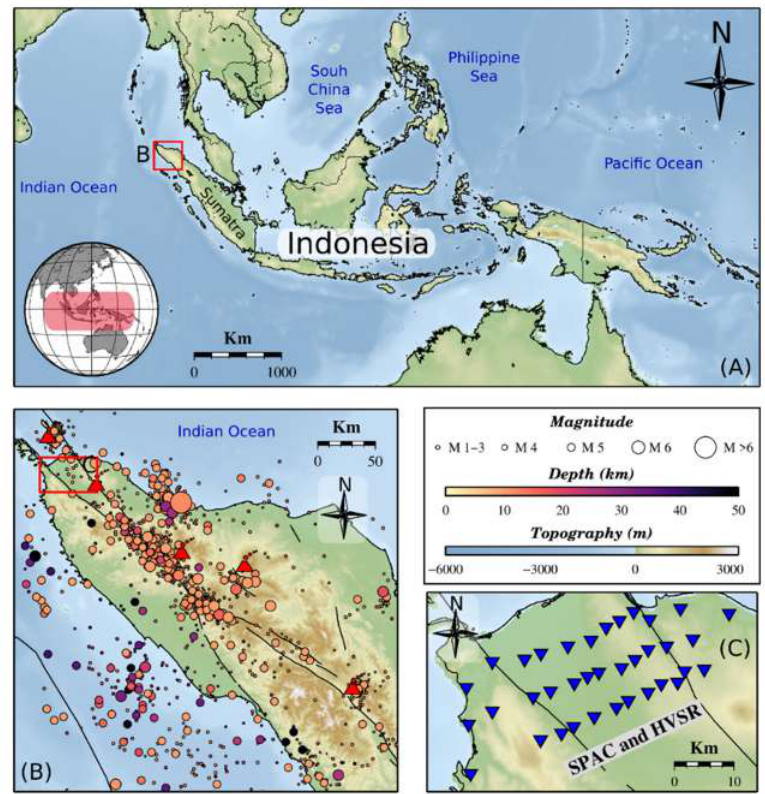
Fig. 1: (a) Geographical map of Indonesia and the study area in the Aceh Province. (b) Seismic activities map of Aceh Province showing earthquake distribution that mostly occurred along active faults and subduction zones. The red square marks the study area for this study in the Banda Aceh city and its surrounding. (c) The Study area in the Banda Aceh city and its surrounding and the observation points (blue triangle) while Aceh fault in the left part and Seulimeum fault in the right part (black line).